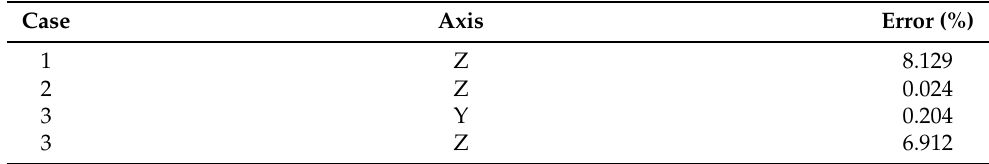
Table 3. Error for Timoshenko beams simulations.